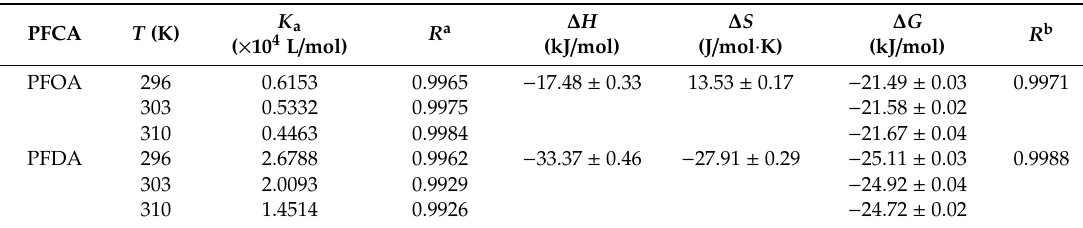
Table 2. Modified Stern–Volmer association constants K a and relative thermodynamic parameters of the PFCA–HSA system at di ff erent temperatures.